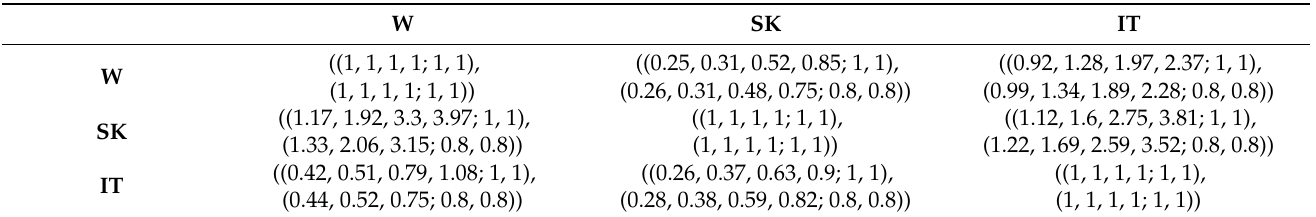
Table 6. Pairwise IT2F comparison matrix- Device factors.